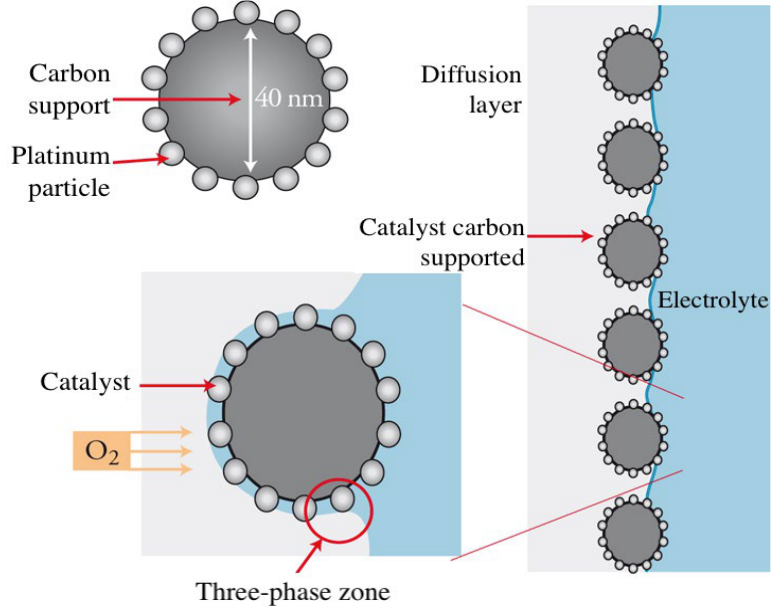
Figure 8. Electrode configuration.